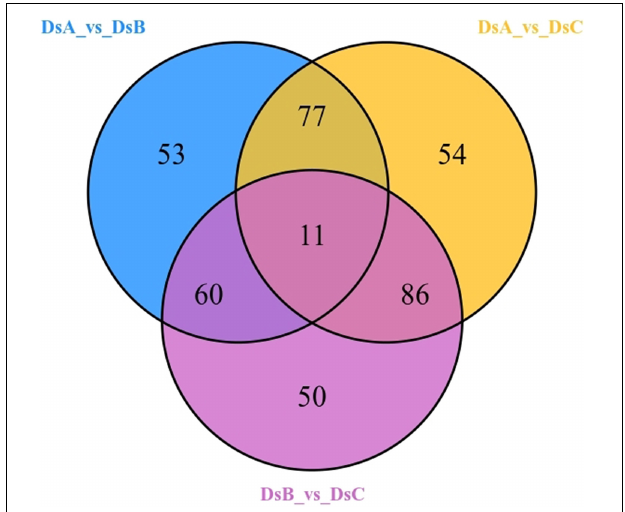
FIGURE 2 | Differential metabolites by Venn